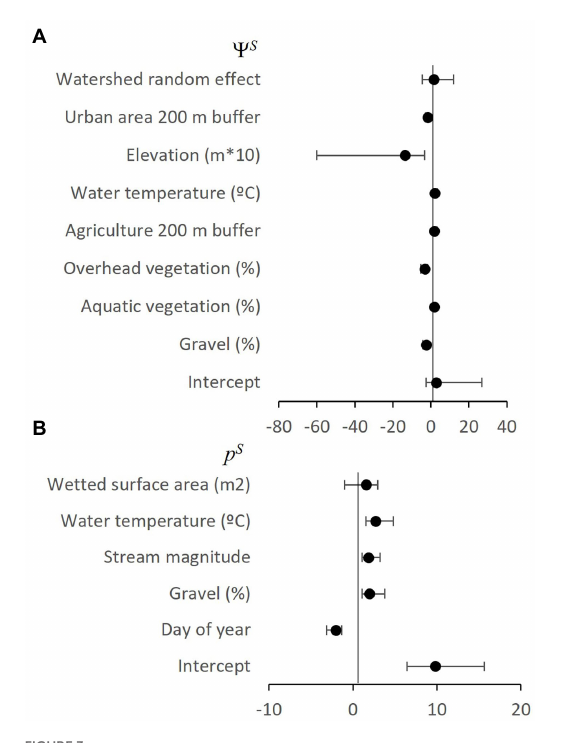
Non-native smallmouth bass occupancy ( A : Ψ S ) and detection ( B : p S ) parameter estimates, with upper (UCI) and lower (LCI) 90% credible intervals estimated from best approximating 2SMS model from the Umpqua basin, Oregon, United States. Note, negative estimates were converted to positive odds ratios to aid